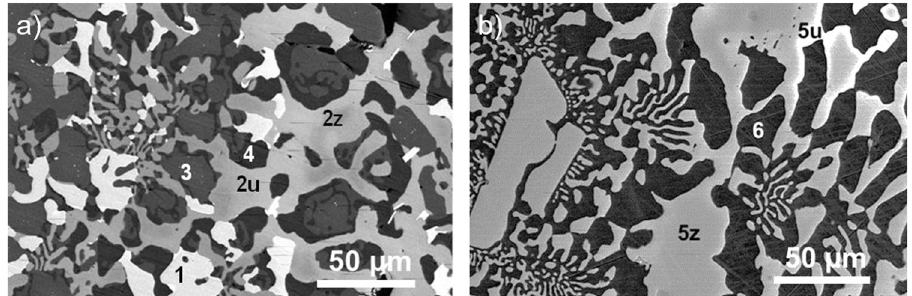
Fig. 1 SEM micrographs of multiphase alloy nuclear waste forms. Showing results for a RAW-2 and b RAW-4. The scale bar on the images is 50 µm.